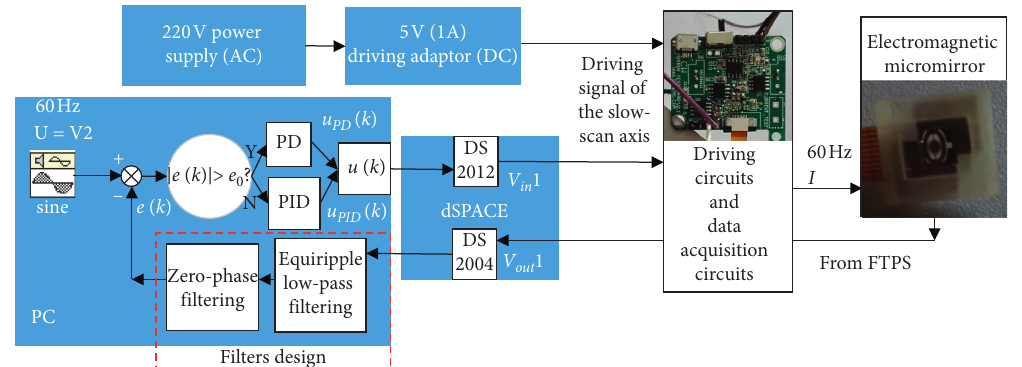
Figure 8: Structure diagram in slow-scan axis control.